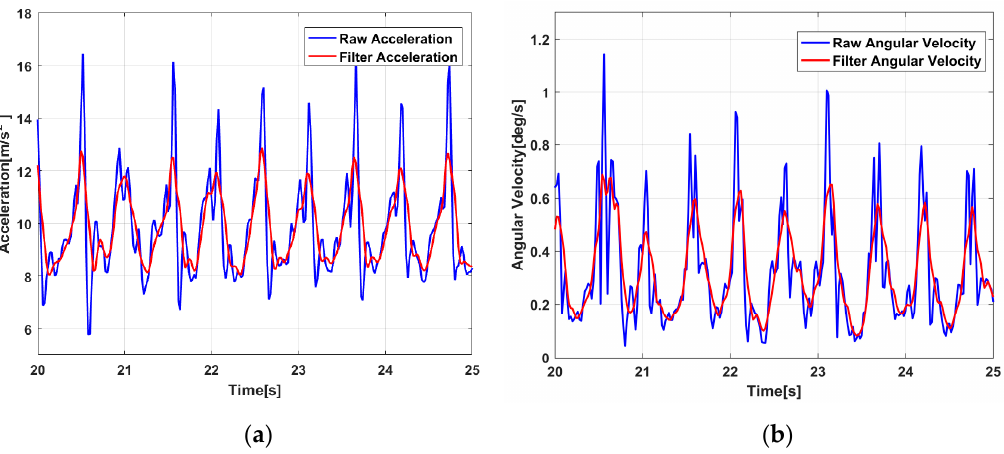
Figure 2. Data filtering and smoothing from the accelerometer and gyroscope: ( a ) the raw and filtered acceleration data; ( b ) the raw and filtered angular velocity data.